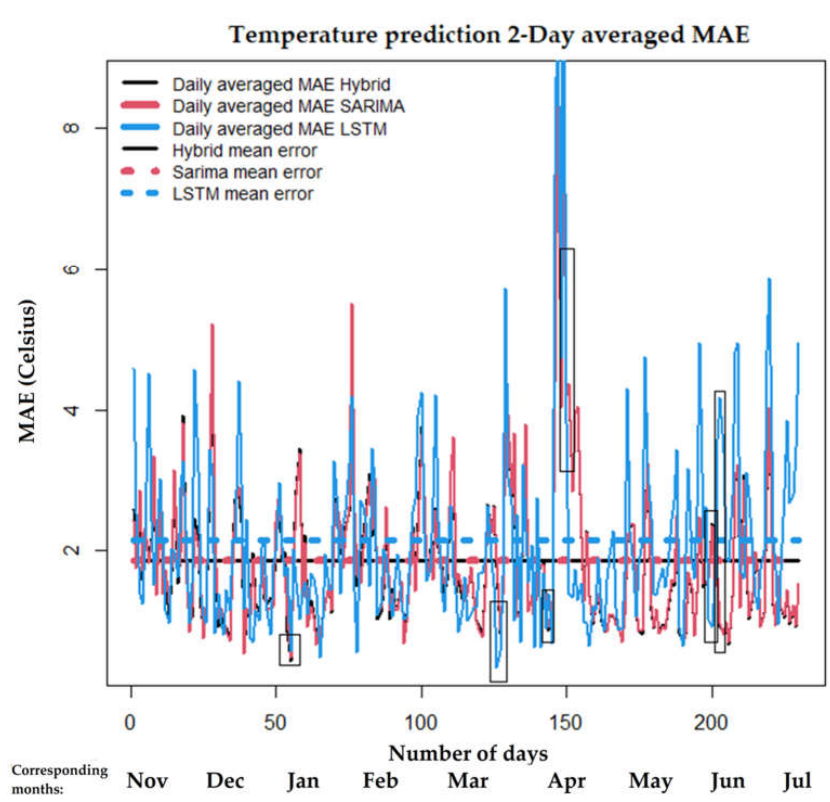
Figure 3. Comparison of SARIMA, LSTM and hybrid using daily averaged MAE with real data for 2-day prediction horizon for 230 days of the test set. With dashed lines the average error of all the dataset is shown. The boxes indicate the predictions that we plot separately to observe their 48-h behaviour. Units of MAE are in Celsius in this temperature example.